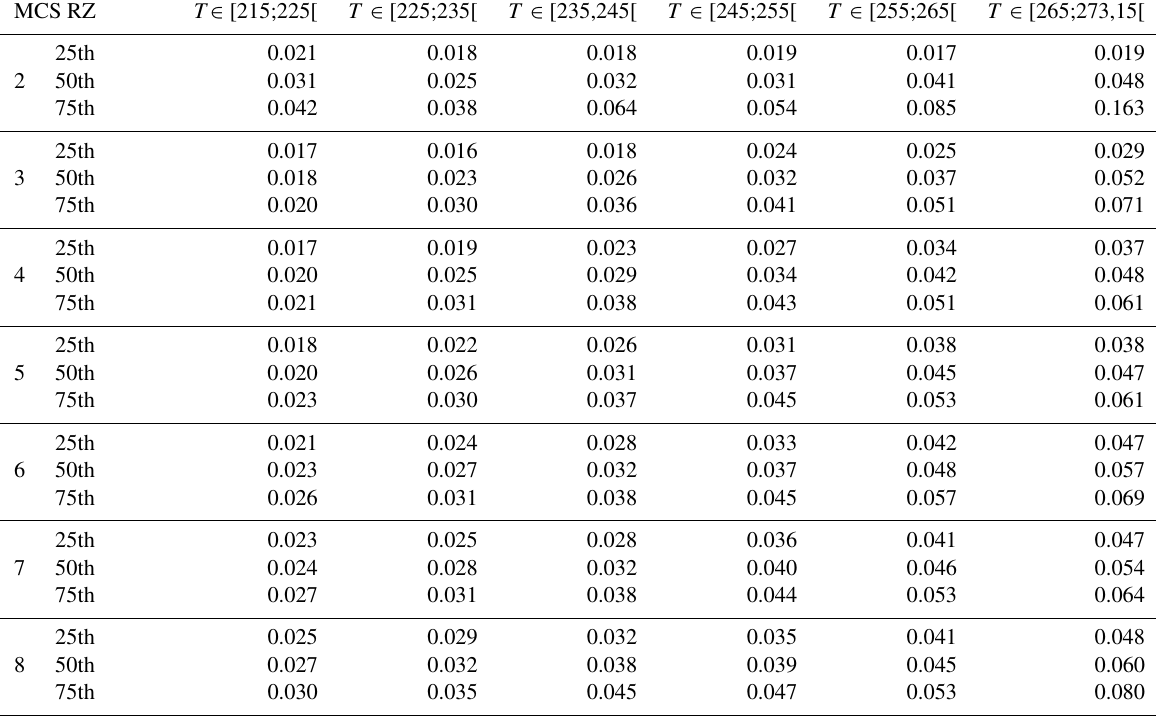
Table C12. Coefficient A in kgm − 2 (Fig.